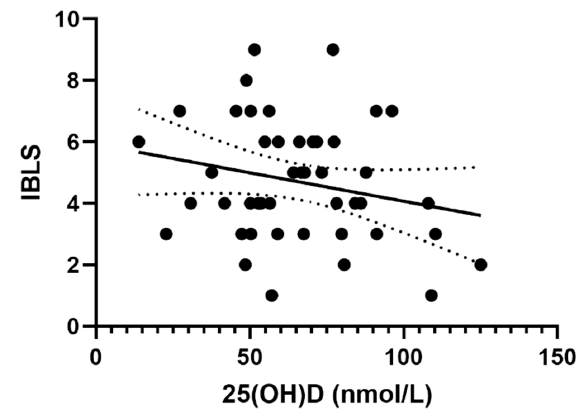
Figure 2. Graph of linear regression between Vitamin D (VD) value and ITP Bleeding Scale (IBLS) score. The mean slope was − 0.018, with the intercept at 5.92, while the 95% CI was at − 0.04 to − 0.005 (intercept 4.2 to 7.6). R 2 = 0.05, p = 0.13.